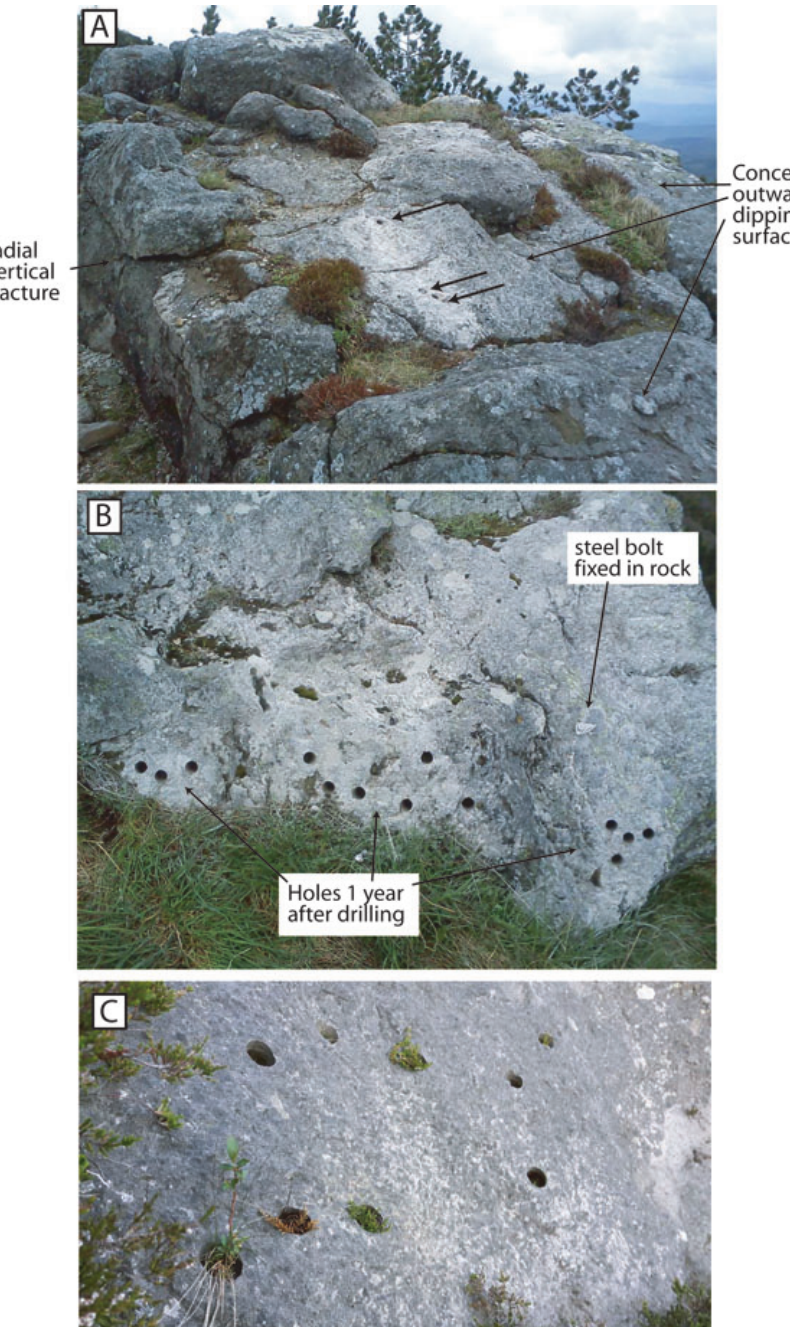
Figure 10: Pictures of sample sites showing how they are integrating back into the natural environment. All sites were chosen to be out of sight of the main tourist paths, in o ff -limits areas. The only exception is for a site near the restaurant terrace, where holes were drilled to be viewed by visitors. Holes were not filled-in, as they return to a ‘natural’ weathered state better with the least intervention. [A] Site PDD9, just below the summit of the Puy de Dôme on a scarp above a slight depression that might be a slumped block. [B] Site PDD1 on the very summit of the Puy de Dôme, next to the terrace on the café (note steel ring on rock). [C] Site PDD4 on the north side of the Chemin des Muletiers, the main walking path up the south-east of the Puy de Dôme. dispersion to the predicated dispersion value for the mean VGPs should be consistent with that predicted. latitude of the site (45 . 5° N) [Merrill and McElhinny 1983]. If secular variation has been adequately sam- (Table 1; Merrill and McElhinny [1983]). The estimated pled, the observed angular dispersion estimate of site dispersion ( S ) of the thirteen accepted site mean